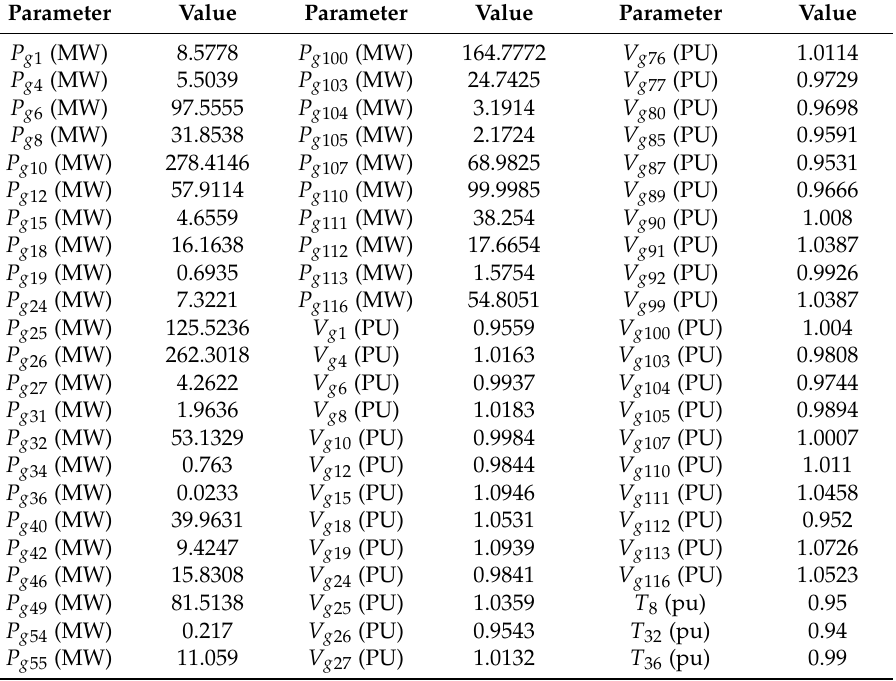
Table A6. Optimal solutions for subinterval 2 of the IEEE 118 -buses system obtained by